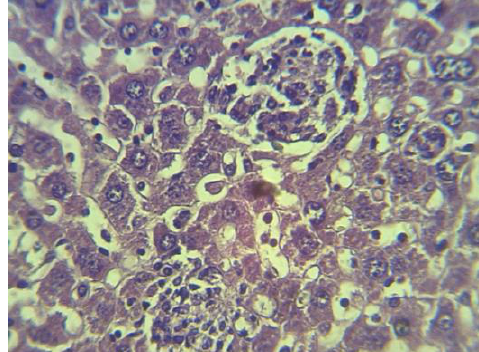
Figure,2 : Histopathological section in the liver of immunized animals with sonicated Ags and treated with chitosan at 30days post-infection shows multiple granulomatous lesions in the liver (H&E stain 40X).